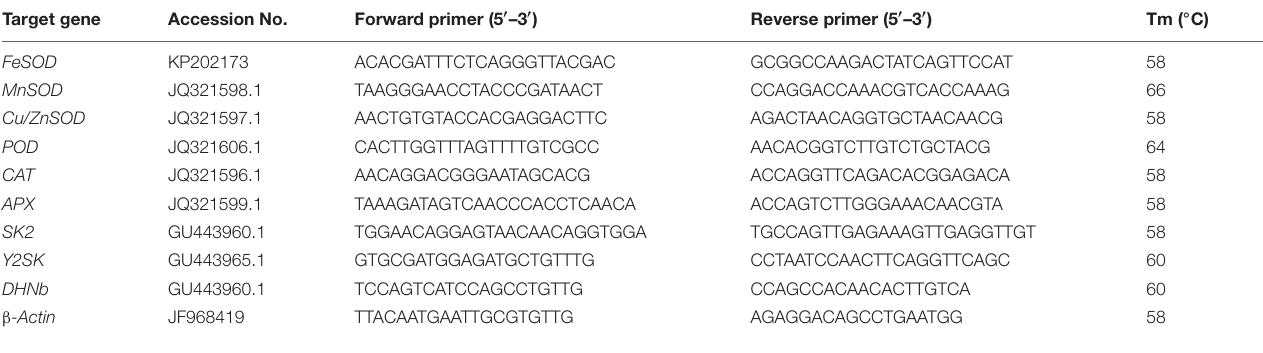
TABLE 1 | Primer sequences and their corresponding GeneBank accession numbers of the analyzed genes. Target